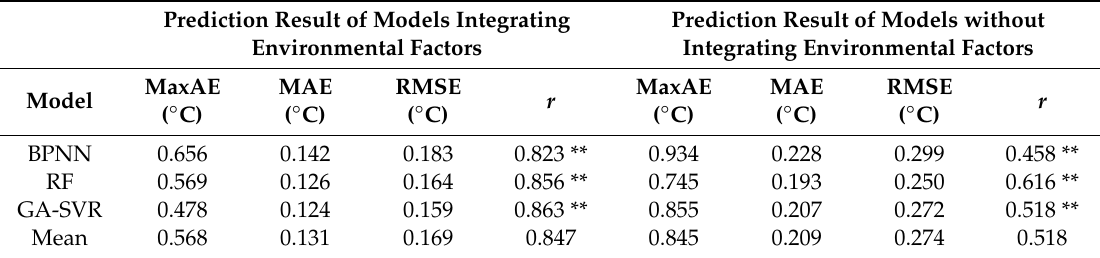
Table 2. With and without environmental in modeling comparison results.